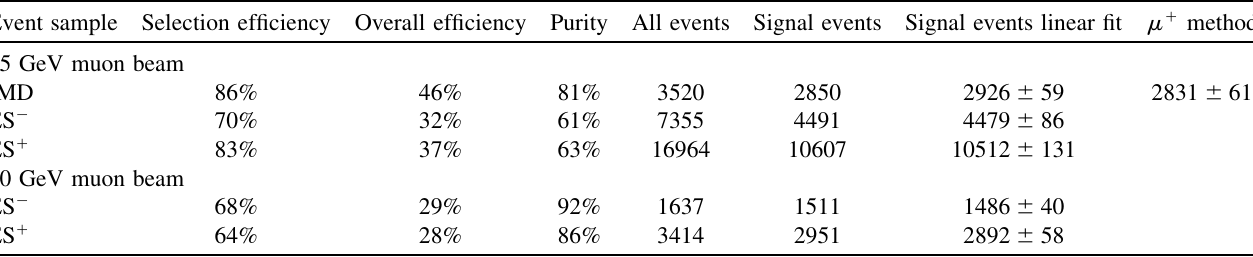
TABLE I. Estimated number of signal events for the three event samples. For the 25 GeV (10 GeV) scenario, the statistics correspond to 2 : 3 (cid:3) 10 19 ( 5 (cid:3) 10 19 ) (cid:3) (cid:1) decays and as many (cid:3) þ decays, which is 9.2% (10%) of a nominal year.